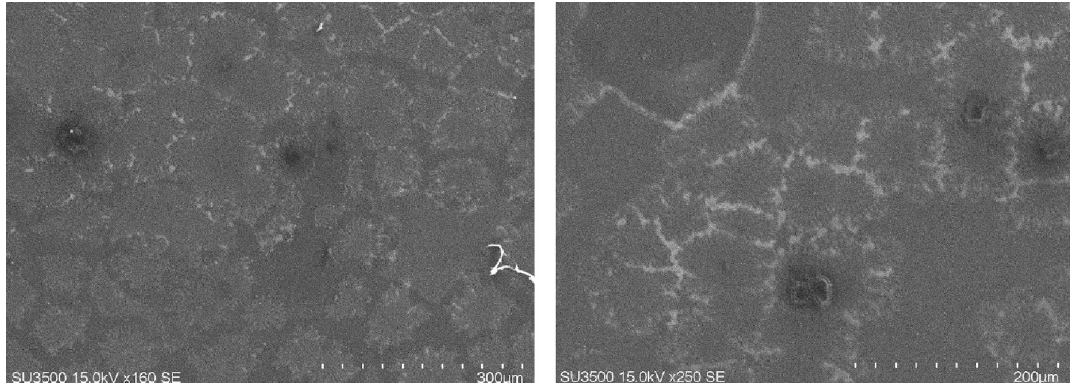
Figure 3. The microscopic image shows the neuron cells were successfully cultured on the plasmonic grating Adding STZ and treatment of the cells by that for 10 days must reduce the activity of the cells, as mentioned previously. The neural activity detection is based on the membrane refractive index and the minimum change in the cellular volume, which shifts the plasmonic sensor’s resonance. Culturing the neuron cells on the gold surface changes the refractive index because the cell membrane alters the dielectric constant of the sensor surface. The sensing is based on detecting the reflective index or changes in the layer thickness. The chip characterization is important before being cultured with neuron cells. The chip was excited, as shown in Fig. 2a. Using a halogen source (broadband) with a wavelength ranging from 400 nm to 700 n and passing through a polarizer. An objective lens will focus on the polarized light with NA = 0.65. On the interface between the dielectric (grading polycarbonate) and metal (grading gold film with a thickness of 35 nm), the SPPs were measured by spectroscopy. With SPPs, an amazing physical phenomenon appears as a sharp transparency window inside a vast absorption spectrum. This phenomenon is known as plasmonic induce transparency (PIT), which originates from the strong destructive interference between wideband states (super radiant mode) and narrowband states (sub-radiant mode) in plasmonic nanostructures. These characteristics are useful for employing optical sensors and enhancing